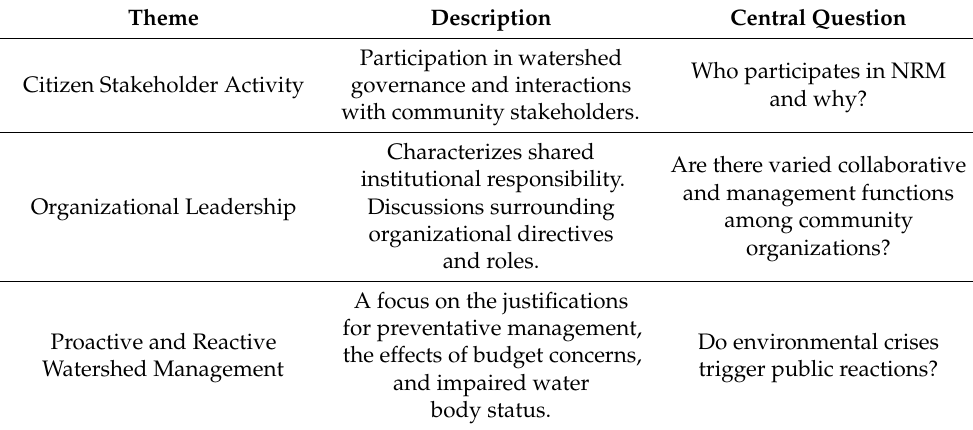
Table 2. Summary of thematic